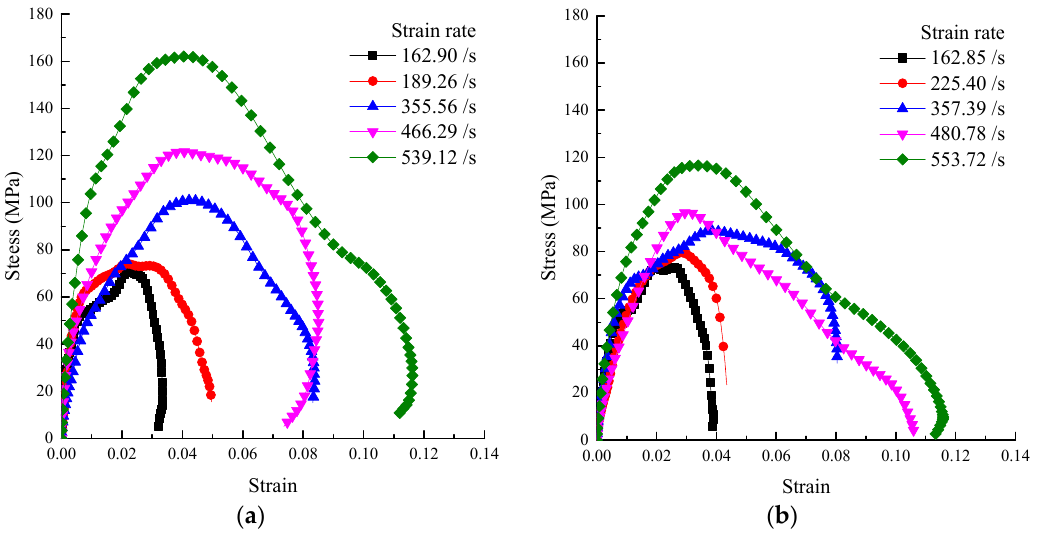
Figure 6. Stress–strain curve: ( a ) Mortar , ( b ) Concrete.